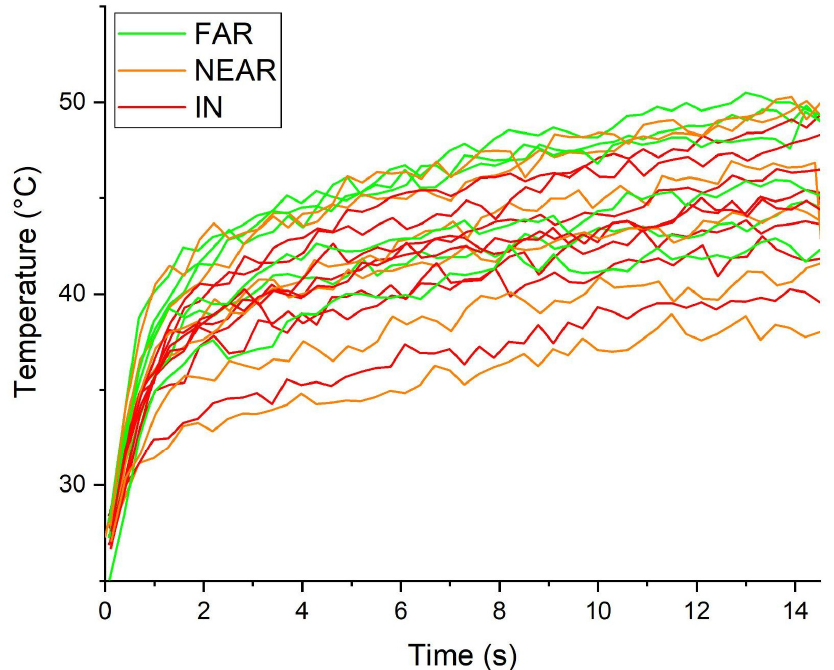
Figure 5. Temperature profiles of the root samples collected inside, near and far from the shallow landslide location.